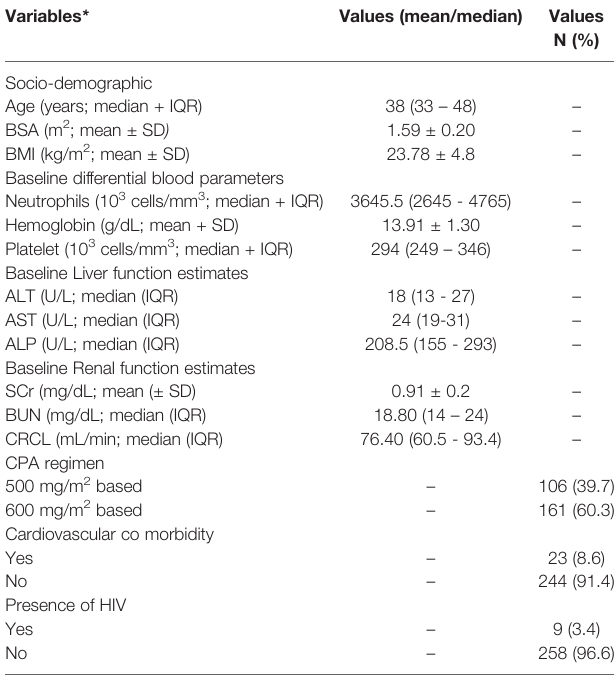
TABLE 1 | Baseline socio-demographic, clinical and laboratory values of